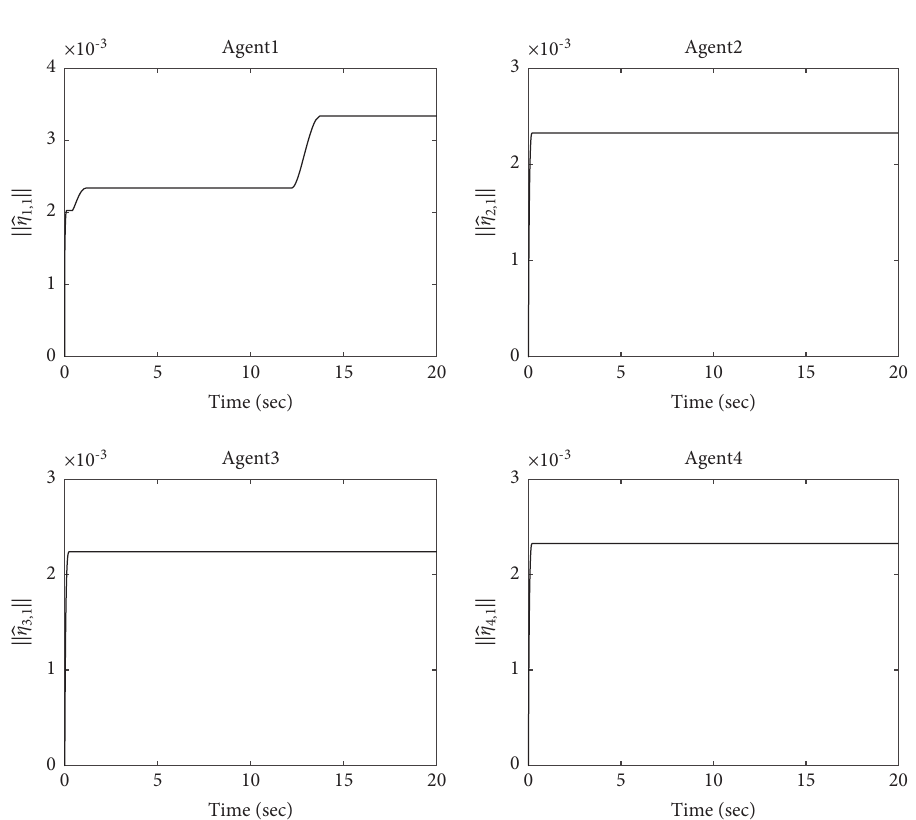
Figure 7: Trajectories of ‖ 􏽢 η